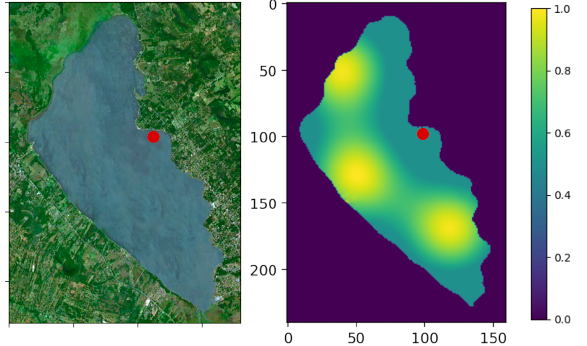
Figure 3. The left image shows a satellite image of Ypacaraí Lake. In red, the initial deploy zone for the ASV. The right image shows the importance map I ( x , y ) that weights the idle index of every zone. The higher the value of I ( x , y ) the most important is to cover this area, either because it is a very contaminated area or holds a high biological